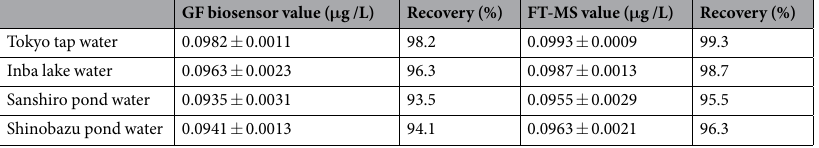
Table 1. Validation results of MC-LR detection using GF electrochemical biosensor and FT-MS method.